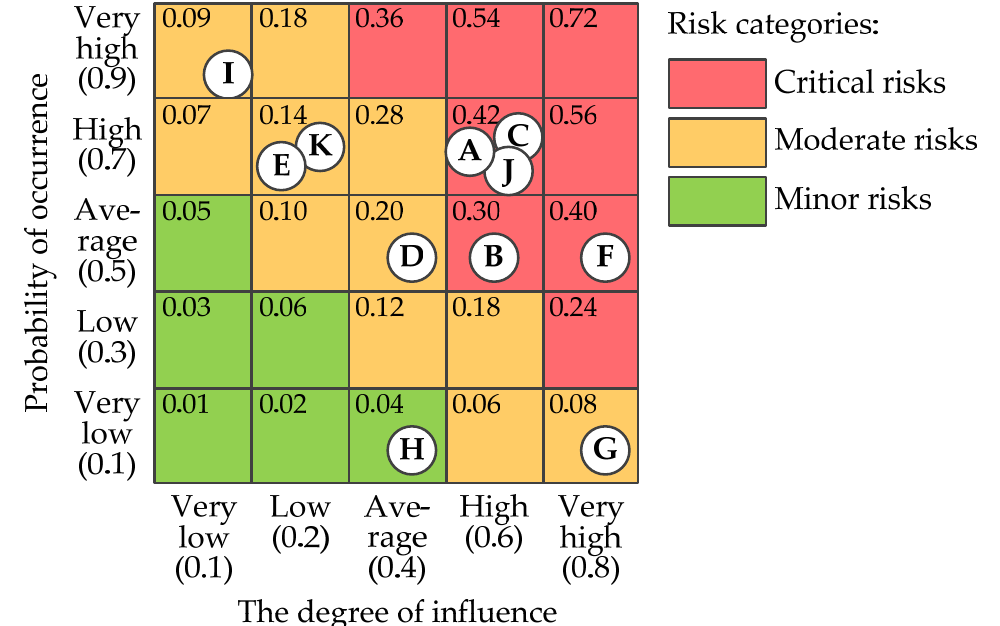
Figure 7. Matrix the transition of problems into risks of the oil and gas industry in Kazakhstan.